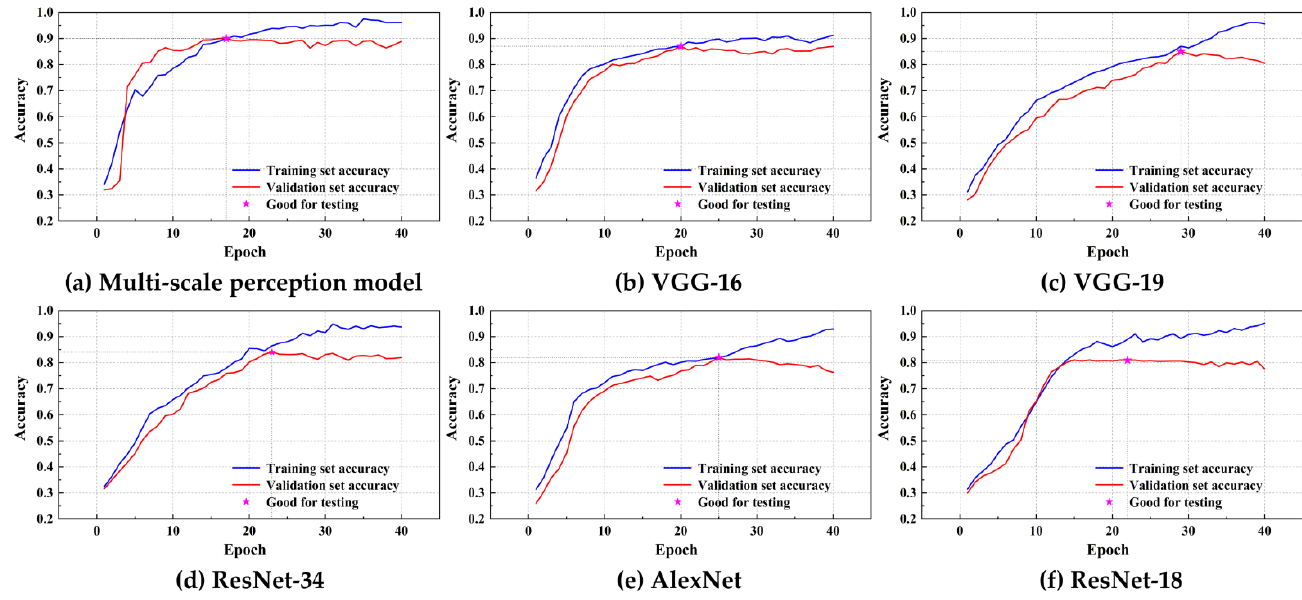
Figure 10. Recognition results of convolutional neural network.